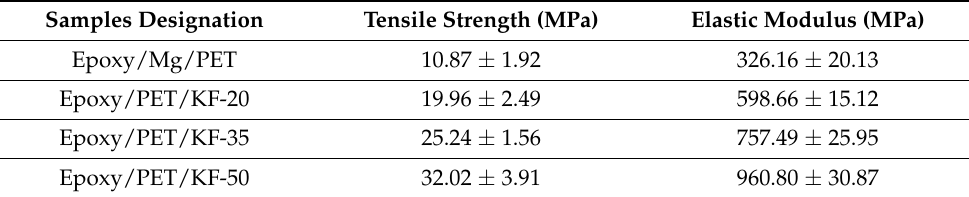
Figure 8. Effect of kenaf fiber loading on the tensile strength of epoxy/Mg/PET, epoxy/PET/KF-20, epoxy/PET/KF-35, and epoxy/PET/KF-50. Table 5. Mechanical properties of hybrid kenaf fiber/PET yarn for all